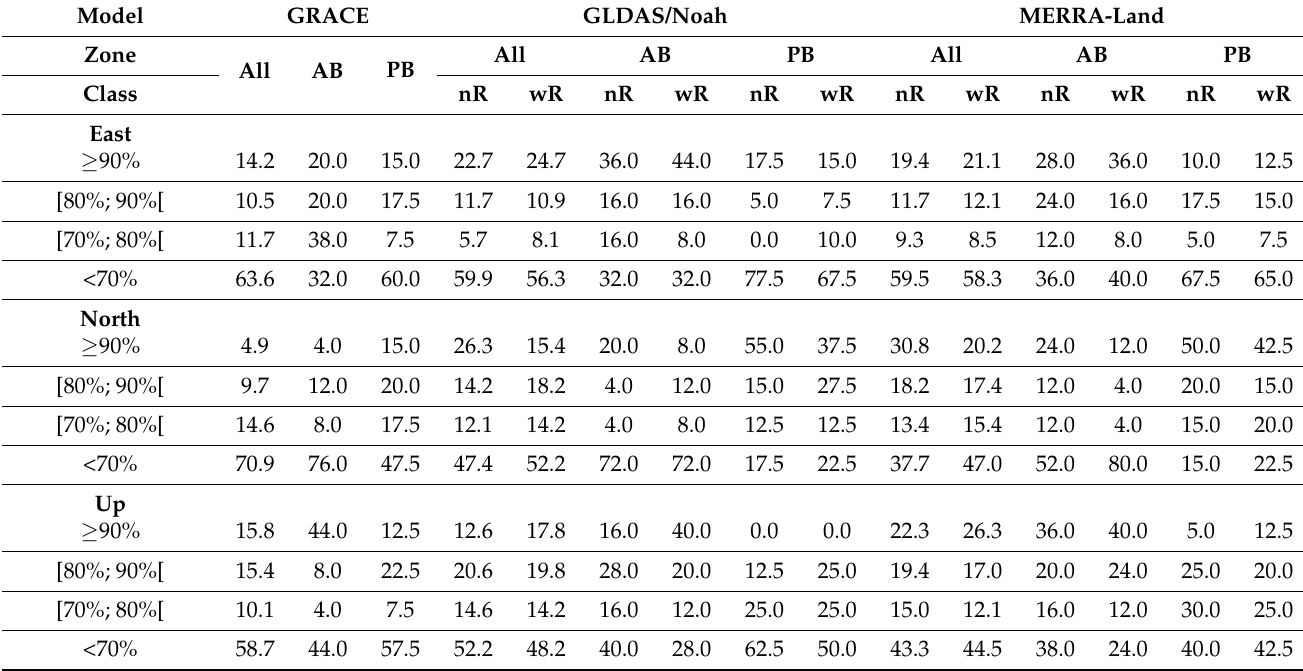
Table 1. Distribution (in %) of the correlation coefficient between GPS and the different models for different subsets of stations: all stations (247), the Amazon basin (25 stations), and the Parana basin (40 stations), designated by the acronyms “All”, “AB”, “PB”, respectively. The loading models without the river are provided in the “nR” columns, the ones including the rivers are in the “wR”